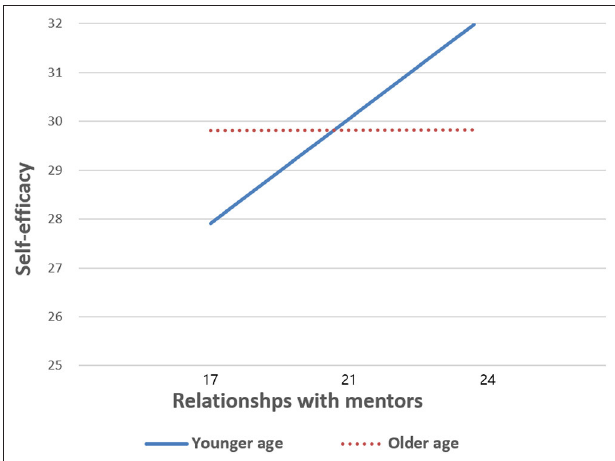
FIGURE 2 | Moderating effect of age on the association between relationships with mentors and self-efficacy among low-income